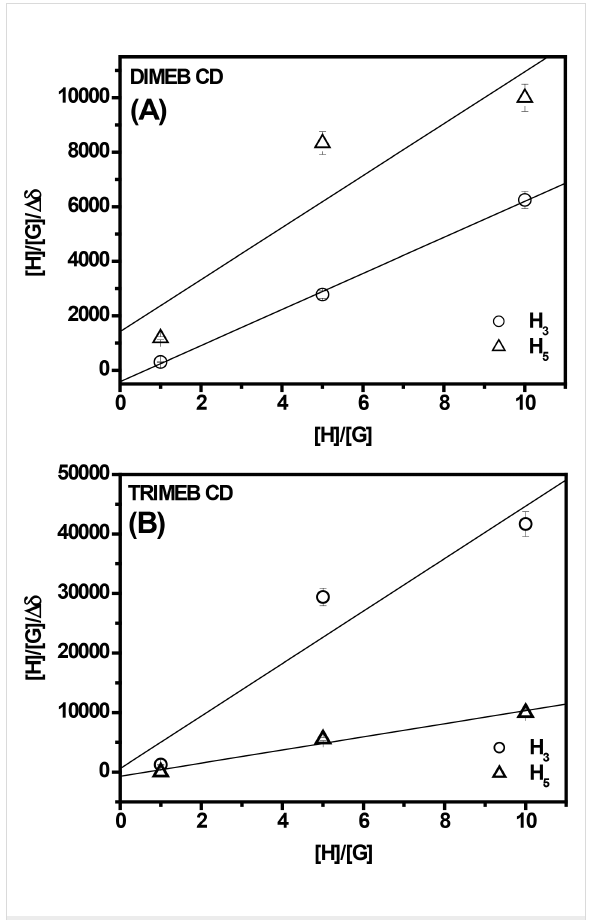
Figure 6: Modified Benesi–Hildebrand plot of [H]/[G]/ Δδ versus [H]/[G] in the presence of S 4 TdR at an initial concentration of 1 × 10 − 3 M. The reported host/guest ratios are 1:1, 1:5 and 1:10. Δδ represents the difference between the observed chemical shift of H3 and H5 protons of CDs, in absence and presence of the guest molecule, i.e., Δδ = δ (complexed state) − δ (free state) . (A) DIMEB CD/S 4 TdR, (B) TRIMEB CD/S 4 TdR inclusion